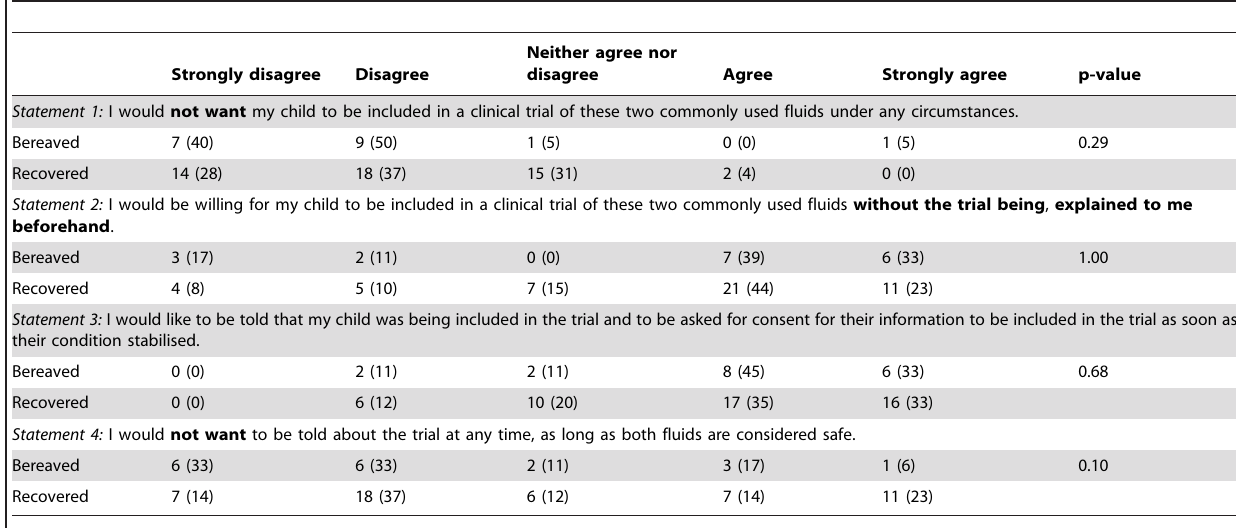
Table 1. Scenario A: If a child of mine had a serious infection and needed emergency fluid